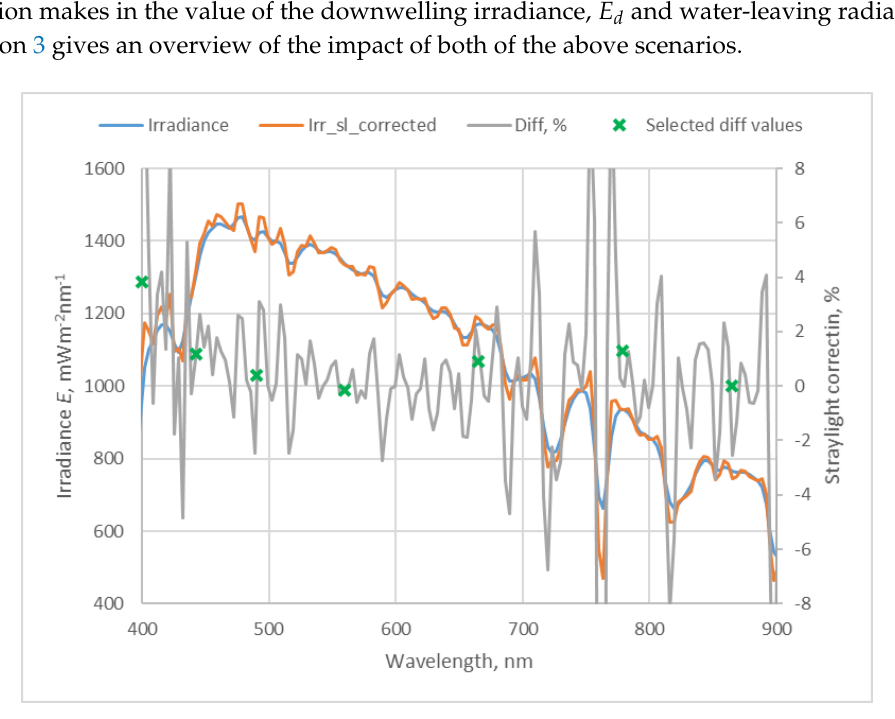
Figure 7. The stray light correction of the irradiance measurements and the percentage difference between non-corrected and corrected. The selected values are calculated using a weighted interpolation